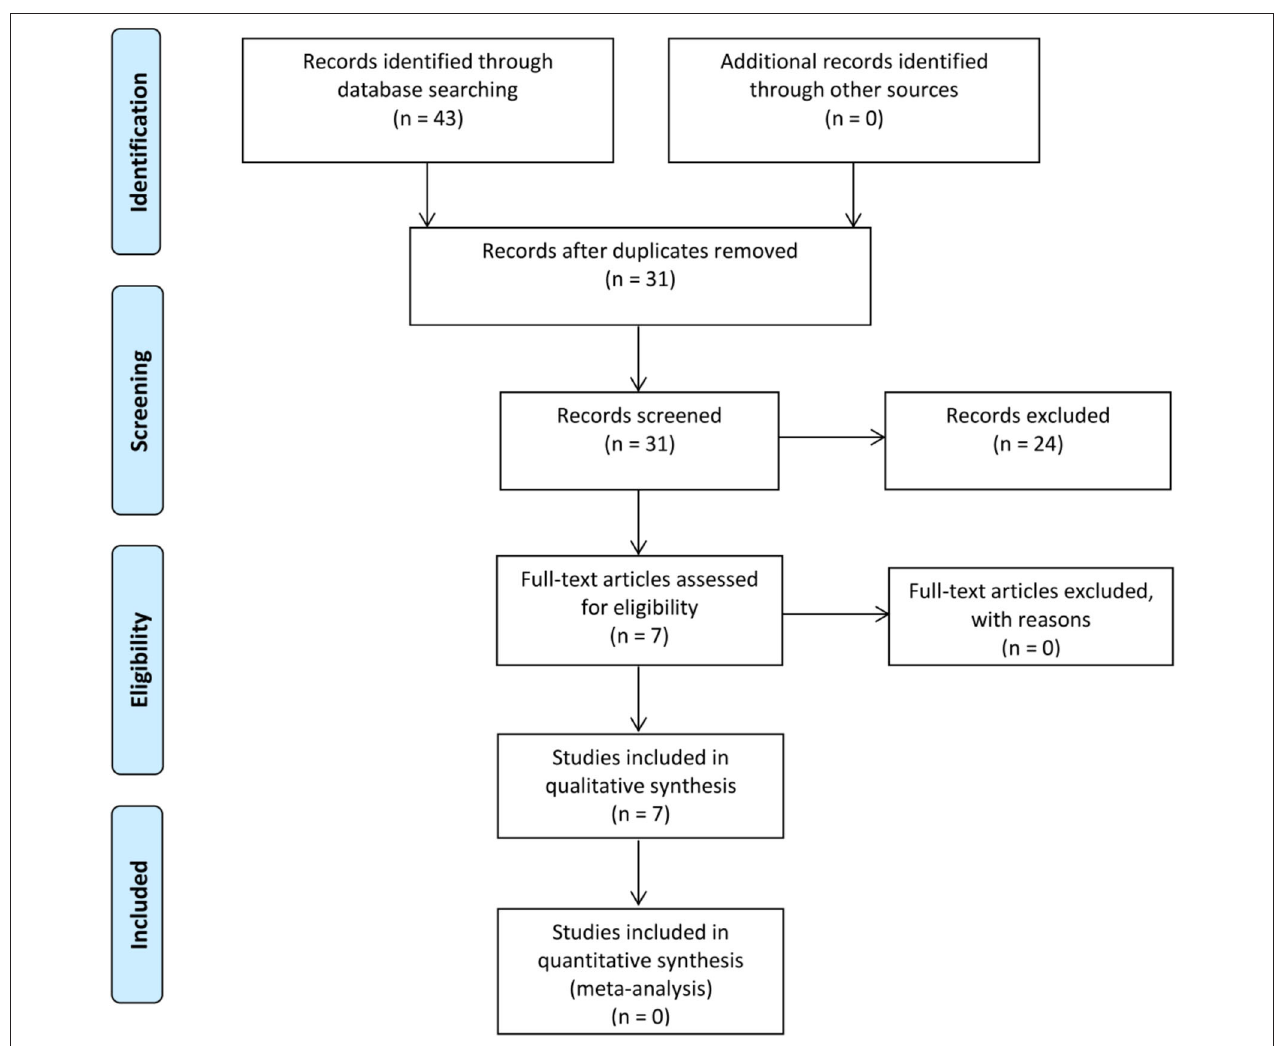
FIGURE 3 | Flow diagram of literature selection process, from Moher et al.